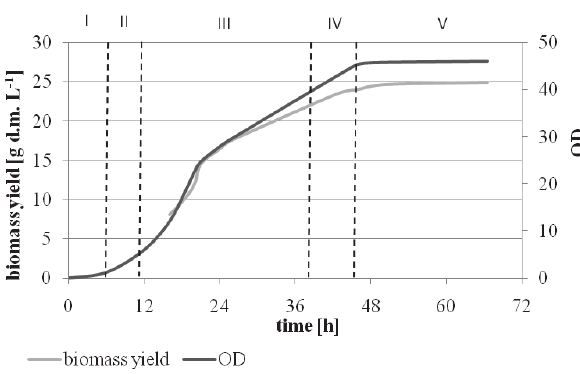
Fig. 1 – Changes in biomass yield and optical density during the batch culture of Y. lipolytica KKP 379. Roman letters mark growth phase: I – adaptive phase (lag phase), II – acceleration phase, III – exponential phase (log phase), IV – phase of de- clining relative growth, V – stationary phase.